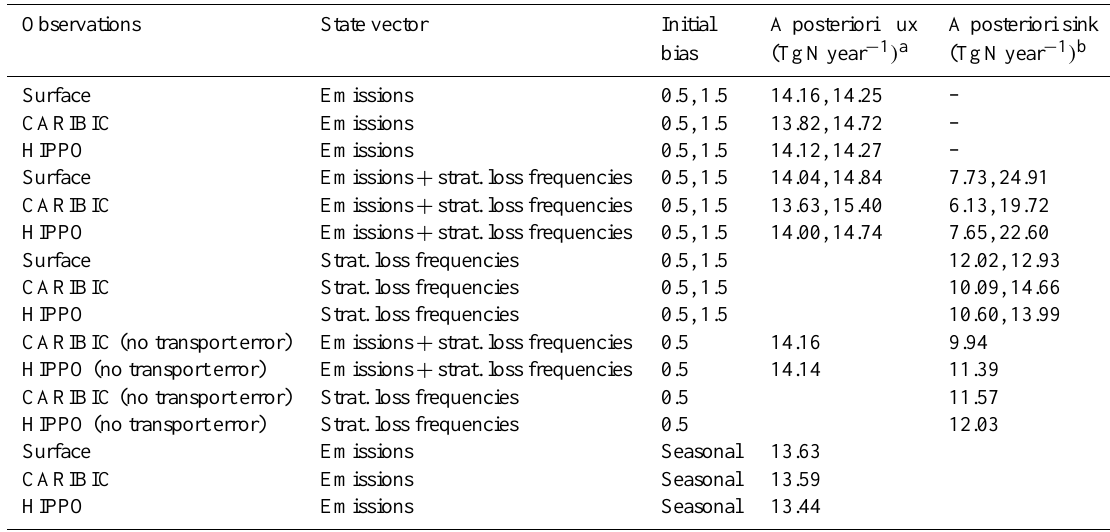
Table 3. Global annual N 2 O a posteriori source for all pseudo observation tests. Observations State vector Surface CARIBIC